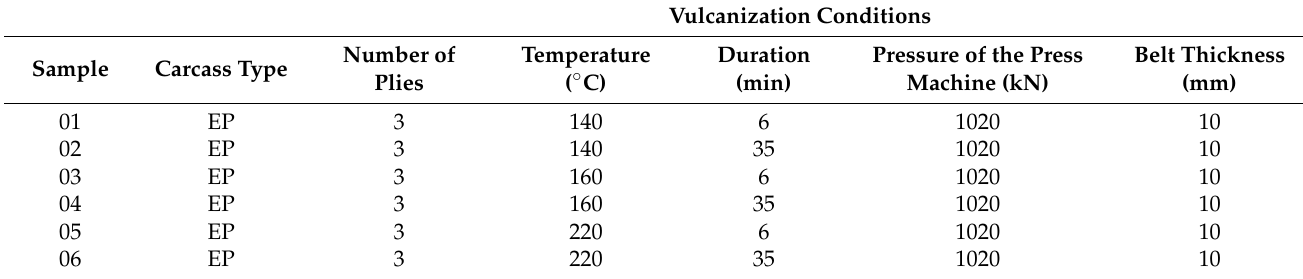
Table 3. Vulcanization conditions of textile ‐ rubber reinforced multi ‐ ply conveyor belt.